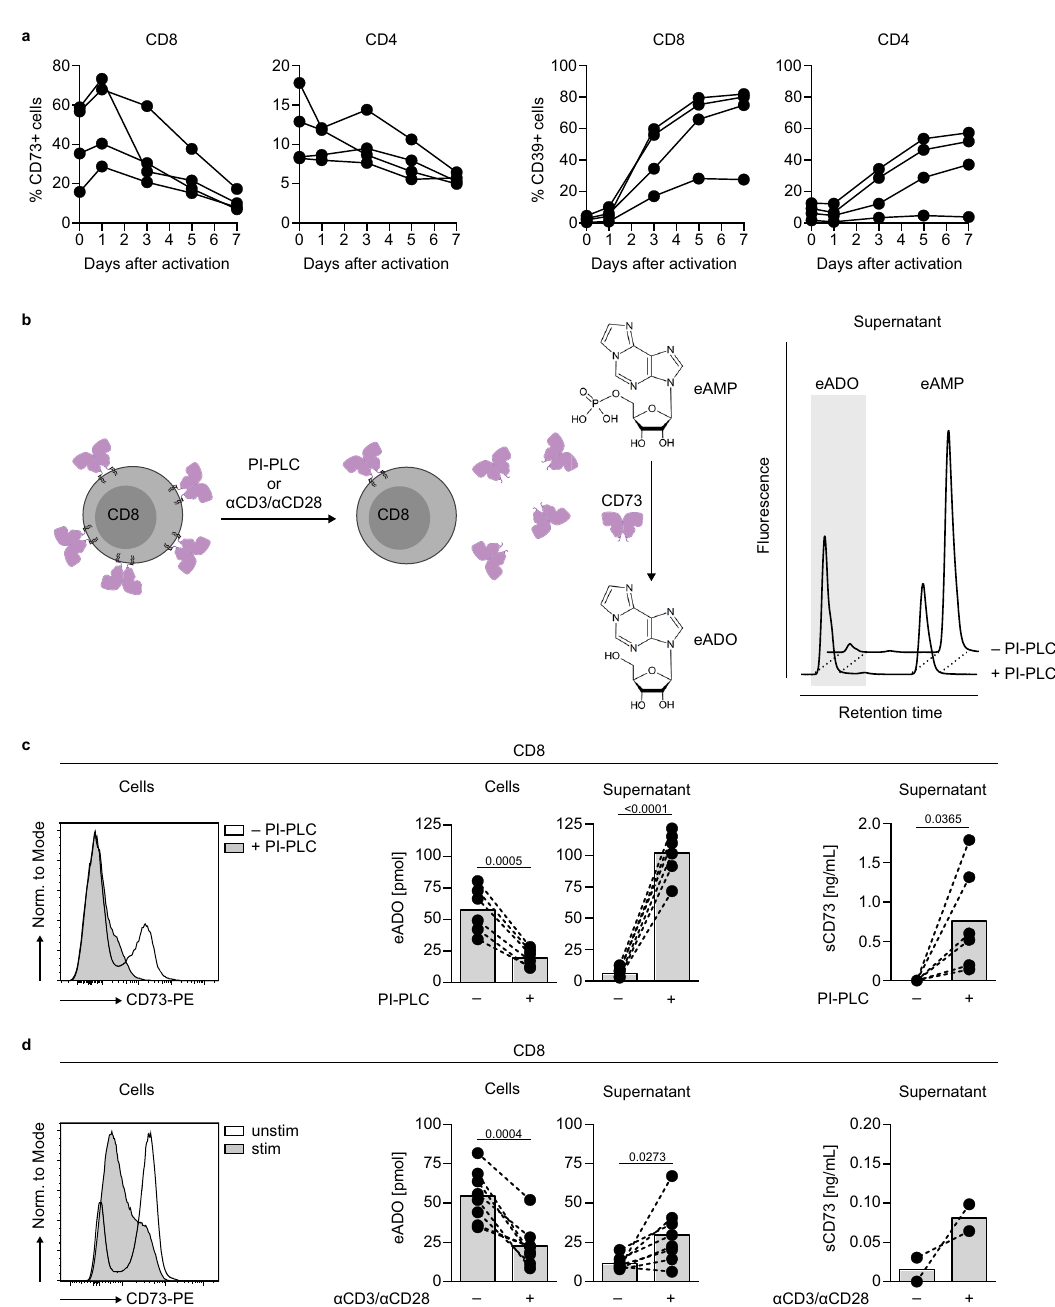
Fig. 3 CD8 T cells release enzymatically active CD73 upon activation. a Flow cytometric analysis of CD73 and CD39 expression on CD8 and CD4 T cells after activation of PBMCs (measurement on fi ve time points from day 0 to day 7). Data were shown for four donors. b Schematic representation of CD73 released from CD8 T cells after PI-PLC treatment or activation. AMPase activity is measured by the conversion of 1, N 6 -etheno-AMP (eAMP) to 1, N 6 - etheno-ADO (eADO). c , d Determination of the AMPase activity of CD8 T cells and supernatants. 0.2 × 10 6 CD8 T cells were treated with c PI-PLC (0.5 U/ mL) or d stimulated with α CD3/ α CD28 for 4 days. Histograms show CD73 expression of the cells at the time of eAMP incubation for one selected donor. The cells and supernatants were incubated with eAMP and degradation of eAMP to eADO was determined by HPLC (middle panel, mean of c six donors and d eight donors). The amount of soluble CD73 (sCD73) was measured by ELISA (right panel, mean of c six donors and d two donors). A two-tailed paired t -test was used to compare untreated and treated samples in c , d